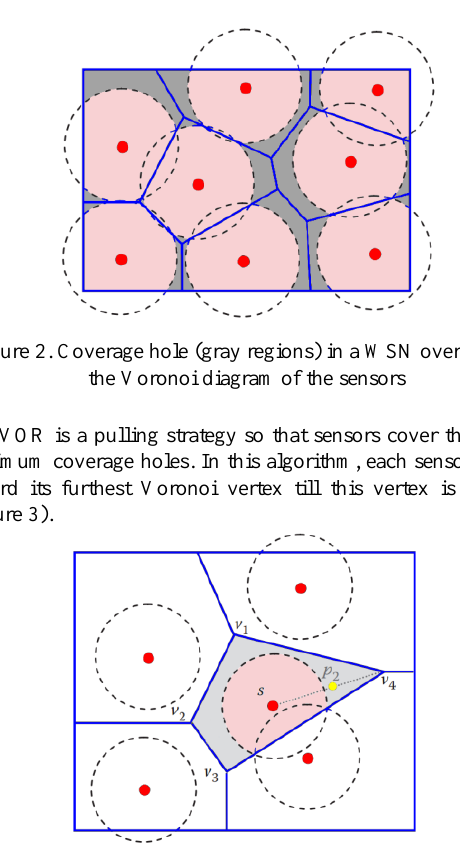
Figure 3. Pulling strategy in which each sensor covers its local maximum coverage